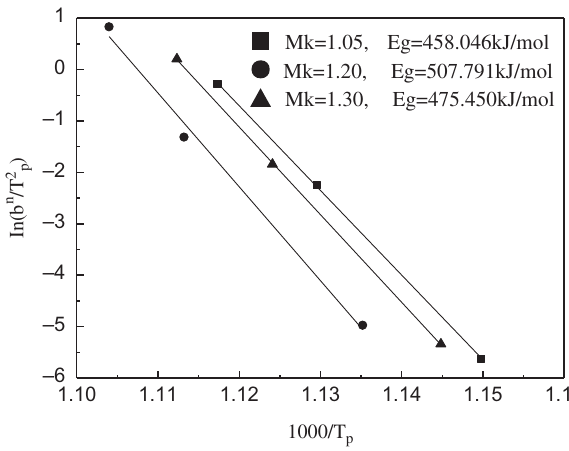
Figure 10: Effect of acidity coefficient on the activation energy.